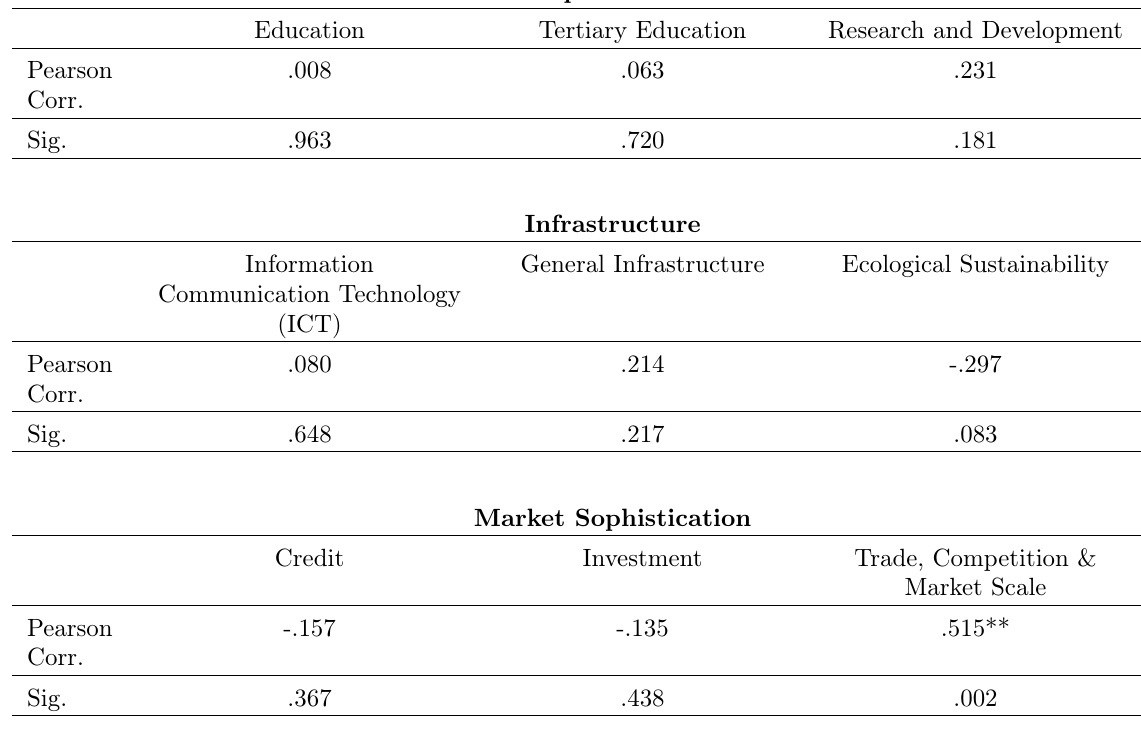
Table 2. Correlations – Change in Innovation Inputs Score with Change in Global Innovation Index Score